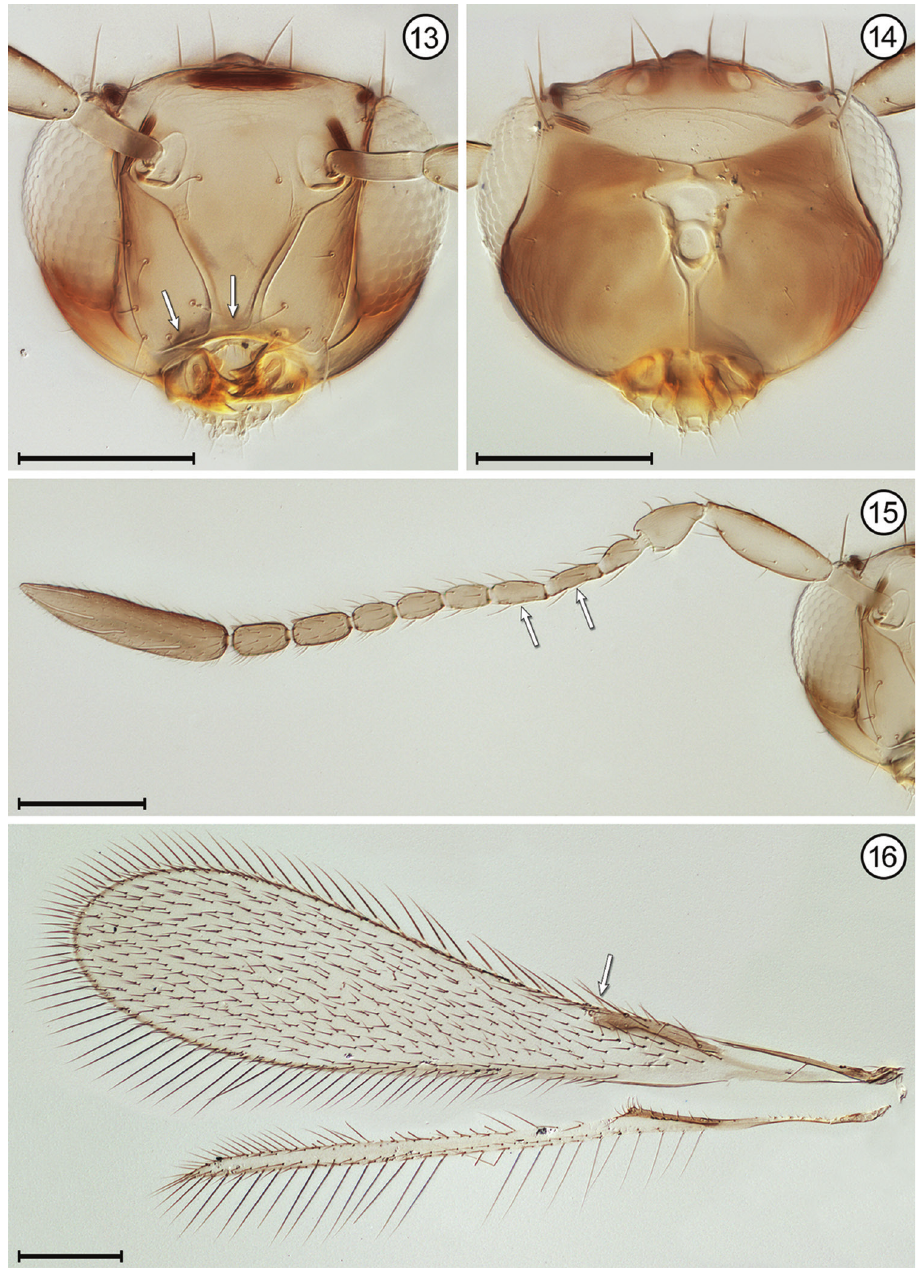
Figures 13–16. Gonatocerus sp., female 13 head, anterior 14 head, posterior 15 antenna 16 wings. Scale bars = 100